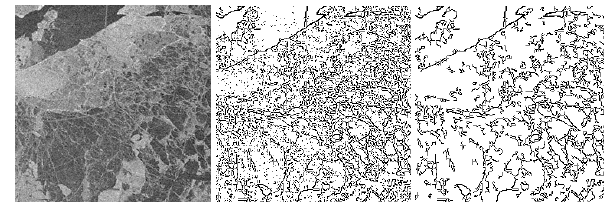
Fig. 7. An example of the SAR edge detection. A small part of a SAR image (left), edges detected by the Canny algorithm (middle), and edges after removal of small edge segments.